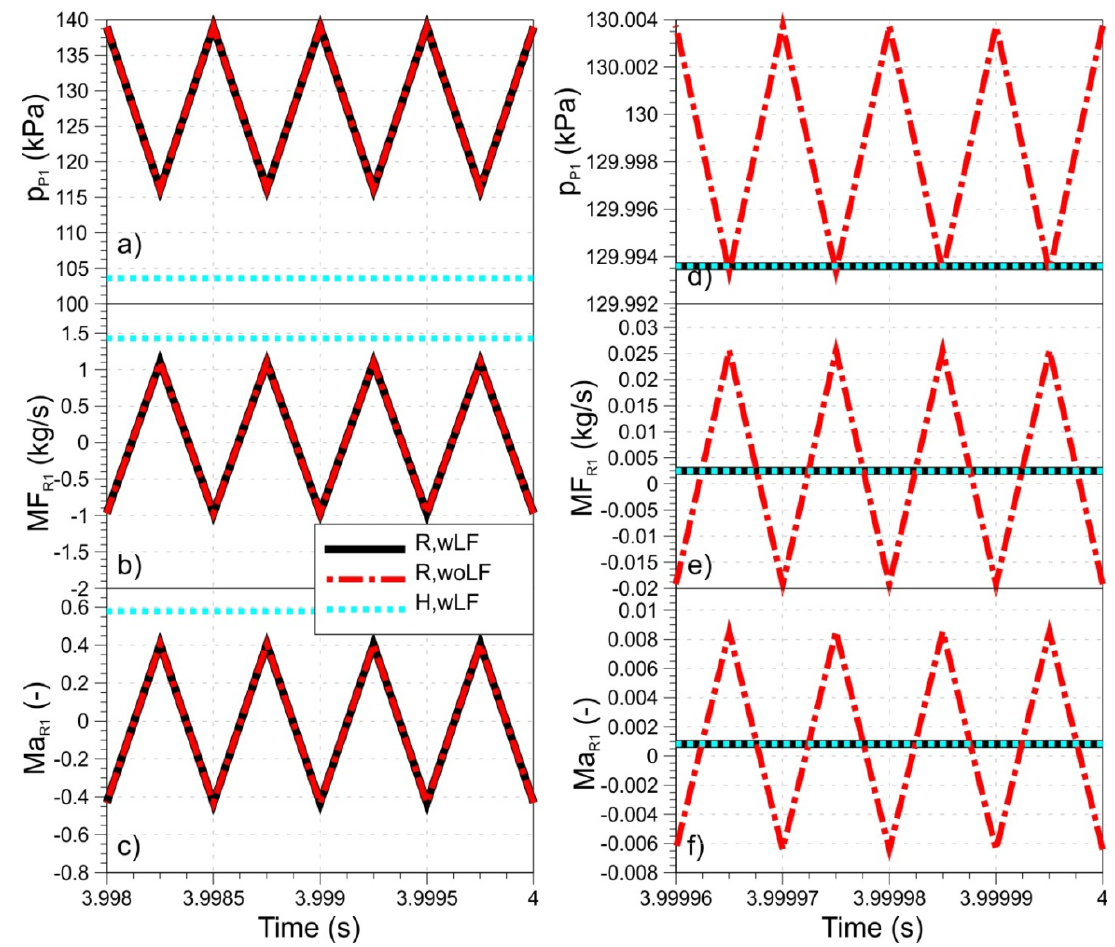
Figure 3. A1-R1-P1-R2-A2: pressure in P1 and the mass flow and the Mach number through the R1 for the time step 0.25 ms ( a , b and c ) and time step 0.005 ms ( d , e and f ). Results are calculated without considering the TMB for Ralston (R) and Heun (H) scheme. Results with (wLF) and without (woLF) assumed laminar flow conditions for very small pressure ratios are